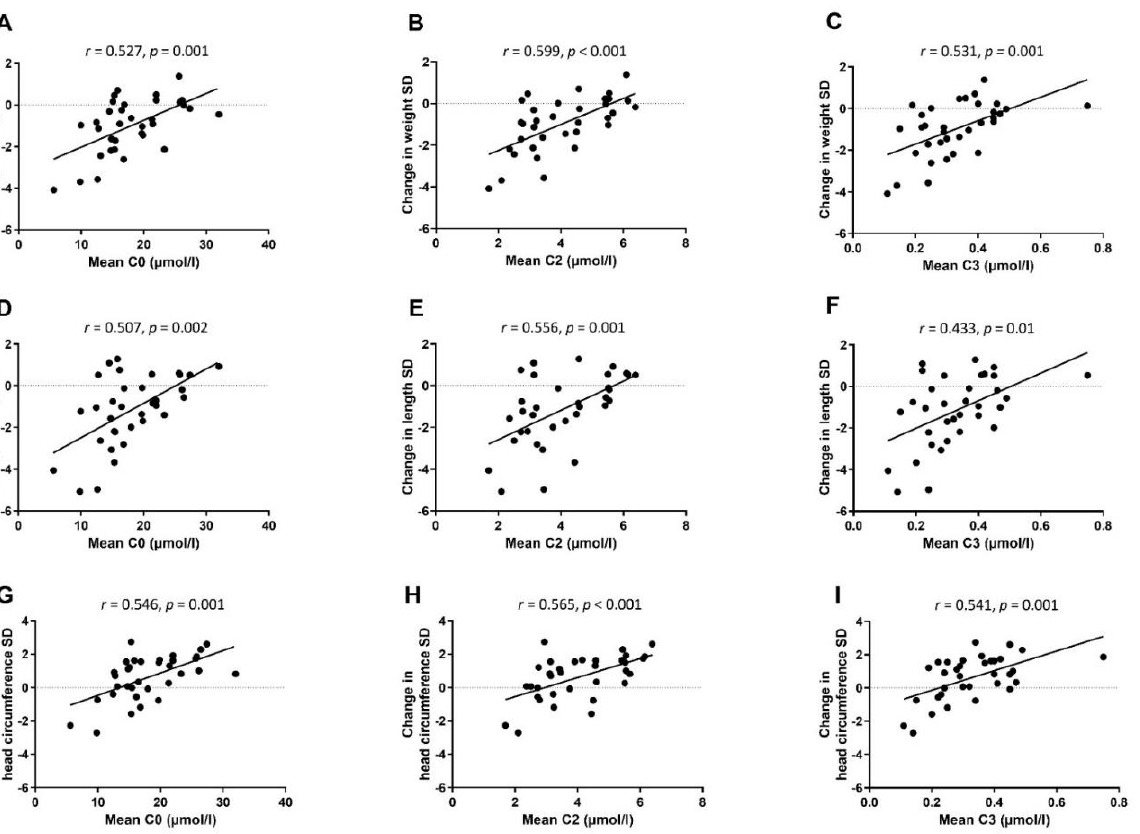
Figure 4. Spearman rank correlations between mean serum concentrations of free carnitine (C0) and short-chain acylcarnitines (C2 and C3) at week 1, week 5, and TEA, and weight ( A – C ), length ( D – F ), and head circumference ( G – I ) Z-score change from birth to TEA.